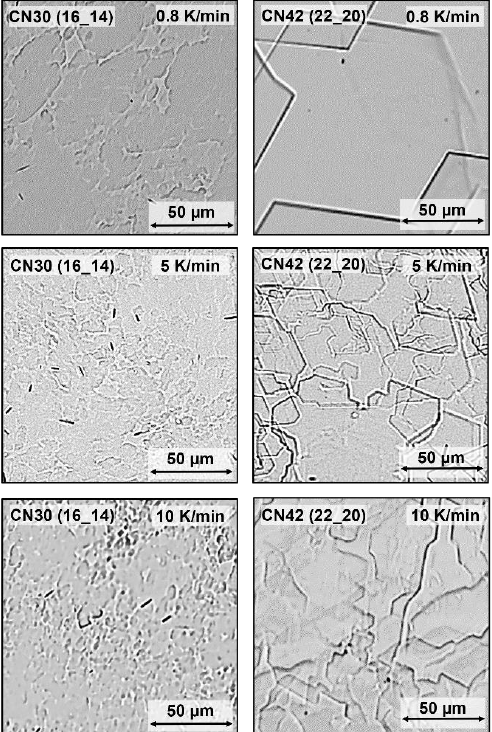
Figure 10. BFM images of WE oleogels (10% [ w / w ] of WE CN 30 (16_14) or CN 42 (22_20) and MCT oil) crystallized at three different cooling rates. The WE are denoted as CN (FaOH_FA).